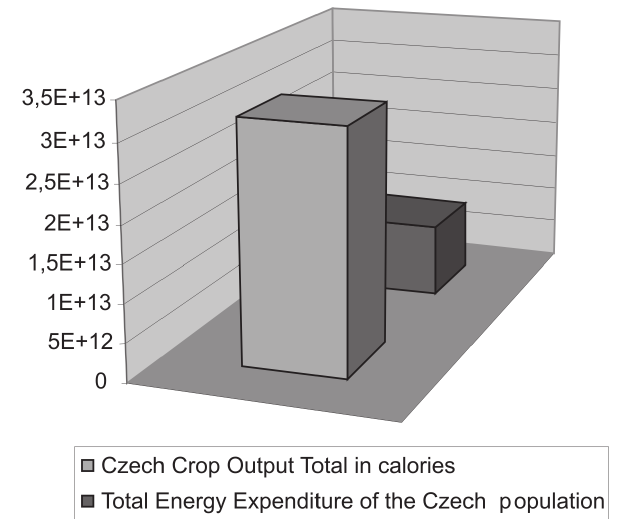
Fig 2. Comparison of the Crop Output Total and the Total Energy